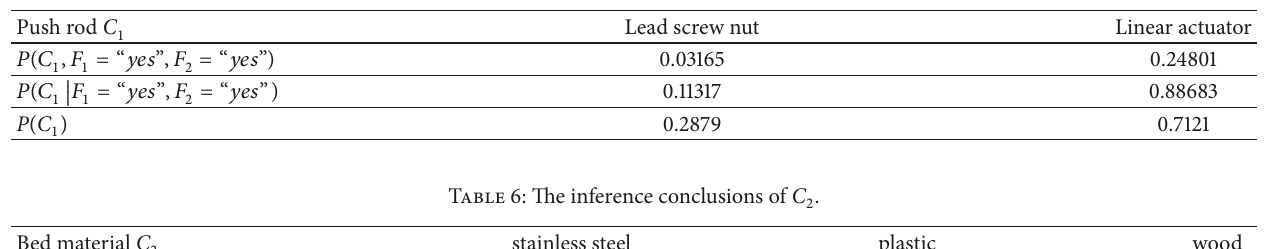
Table 5: The inference conclusions of C 1 .